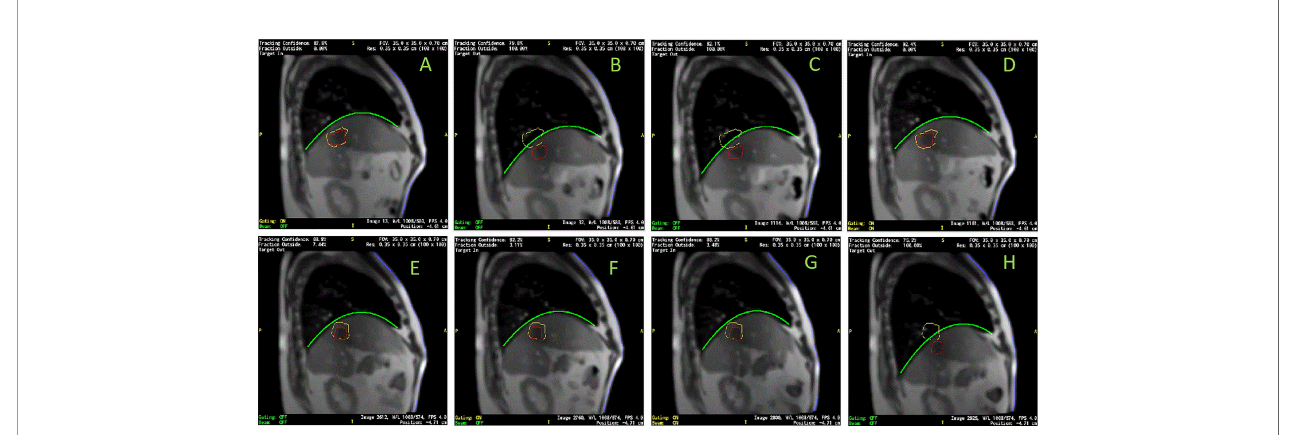
FIGURE 5 | Images selected from two sessions of patient LV13. (A – D) were from Session #3 and (E – H) were from Session #4 as labeled in Figure 4 . Target/ tracking structures are in red; boundaries of tracking structure are in yellow; curve- fi tting results of diaphragmatic curves are in green; anterior skin extracted from body contours are in blue. Frames (A – H) indicate the frames (a-h) labeled in Figure 4